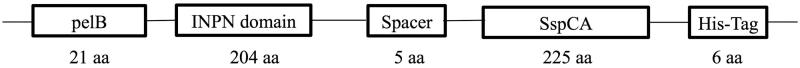
Schematic representation of the gene encoding the chimeric membrane bound SspCA. Legend: pelB, the signal sequence for the periplasmic translocation of the protein (21 amino acid residues); INPN domain (204 amino acid residues); Spacer (five amino acid residues); SspCA: the thermostable CA (226 amino acid residues); His-Tag: histidines at the C-terminus (6 amino acid residues).